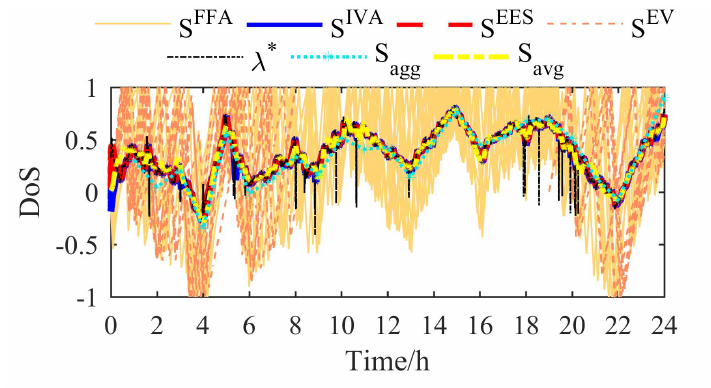
Figure 13. DoS of different GESs and clearing price in Case 2.